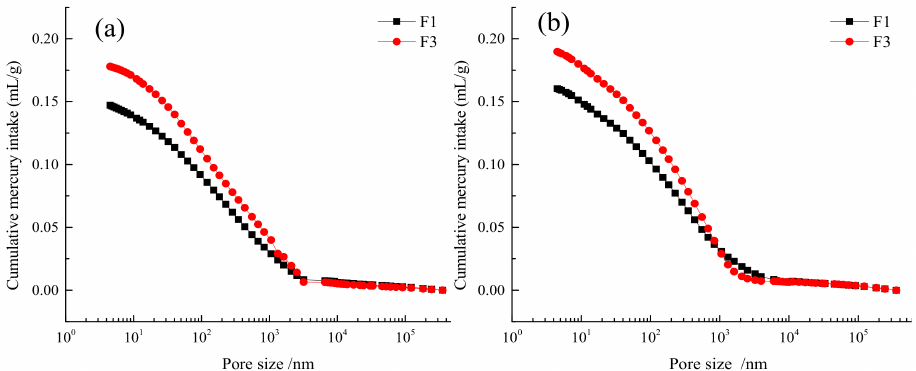
Figure 8. Relationship between cumulative mercury compression and pore size of the filler at different maintenance ages of F1 and F3 groups with high fly ash content: ( a ) 7 d, ( b ) 28 d.